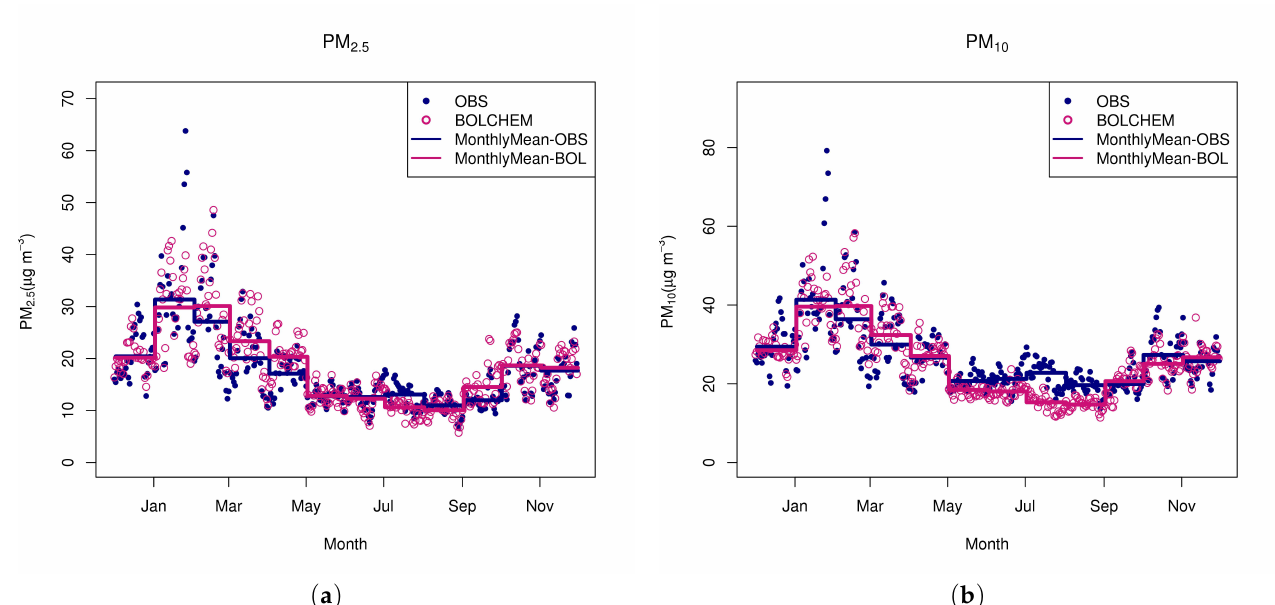
Figure 5. As in Figure 4, but for PM 2.5 ( a ) and for PM 10 ( b ) daily mean values concentration ( µ g m − 3 ).